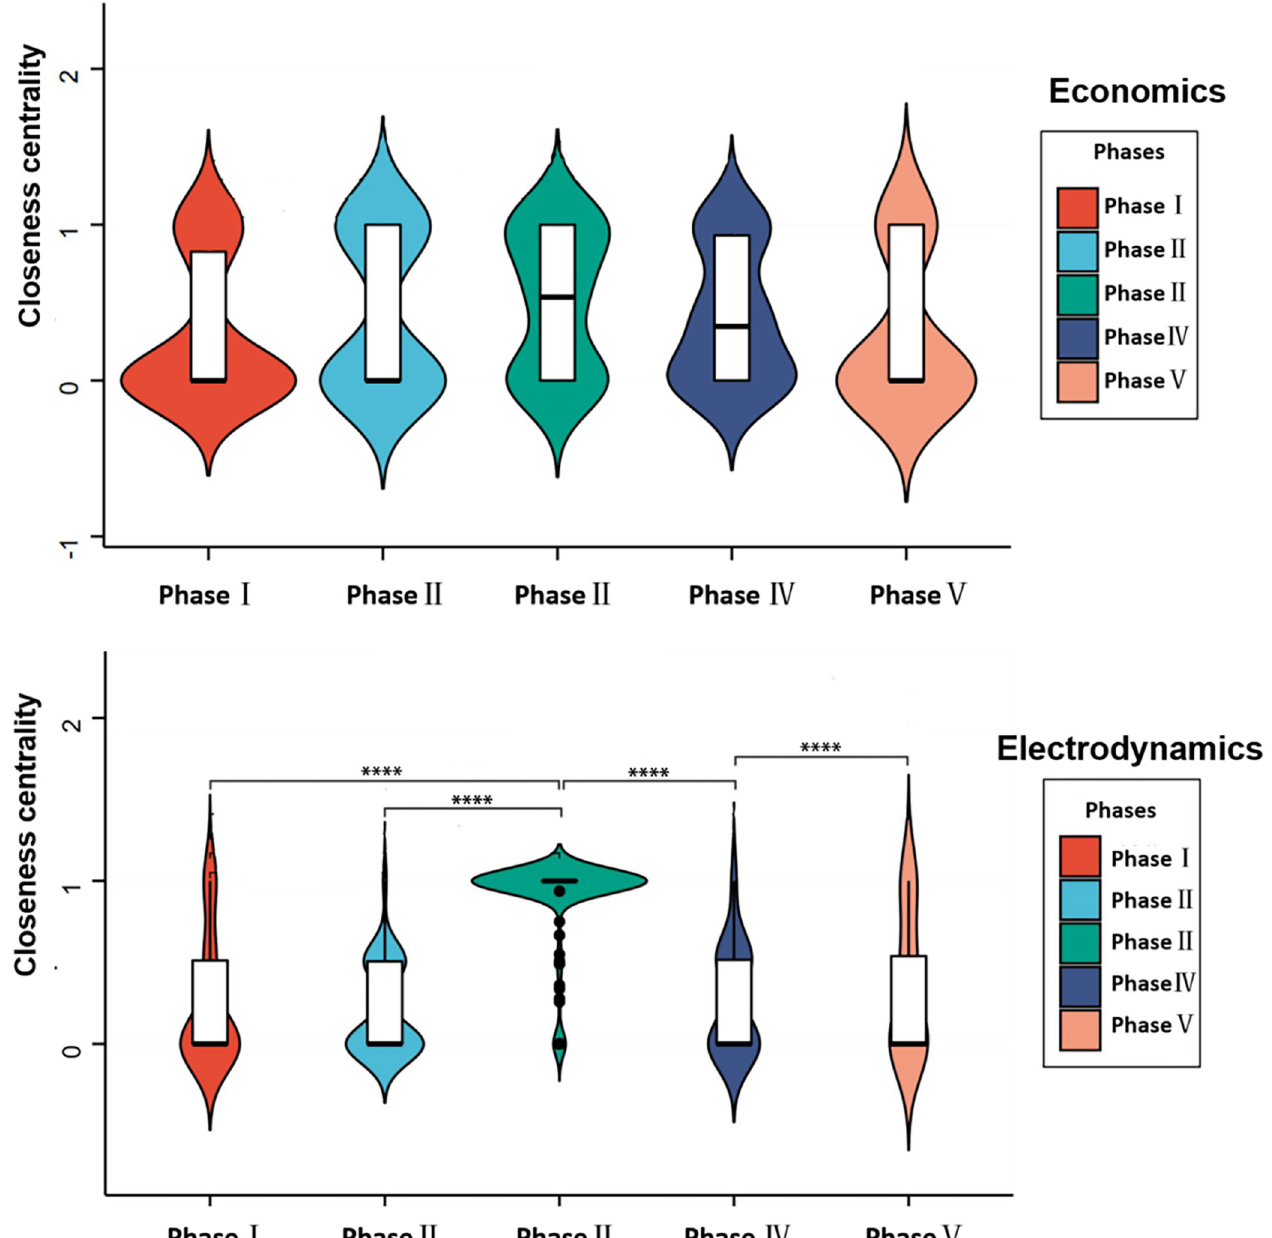
Fig 7. Closeness centrality of Economics and Electrodynamics. (Note: " ���� " indicates the significant distinction in closeness centrality between the two periods, otherwise no significant distinction).